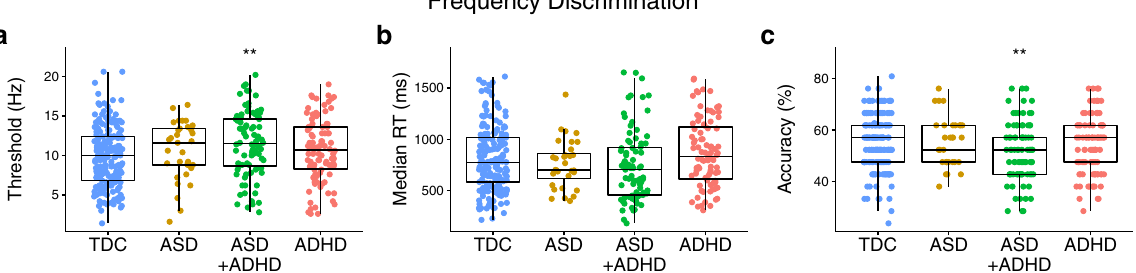
Fig. 4 Group comparisons made on performance outcomes from the frequency discrimination protocol. Individual data points with overlaid boxplots visualizing the group comparisons on key performance outcomes on the frequency discrimination protocol, including a frequency discrimination threshold, b reaction time, and c accuracy. As with amplitude discrimination thresholds, after controlling for age, only the ASD + ADHD group had higher frequency discrimination thresholds than the typically developing control group. Note that all statistical analyses presented in the main text of the manuscript for the plots presented in this fi gure are age-corrected. Values in the plots presented within this fi gure are not corrected for age due to the loss of interpretability of units of measurement that occurs when presenting residuals rather than raw values. The precise number of participants in each group and further descriptive statistics can be found in Supplementary Methods, Supplementary Table 1. * p < 0.05, ** p < 0.01, *** p < 0.001, TDC typically developing controls, ASD autism spectrum disorders, ADHD attention-de fi cit hyperactivity disorder, RT reaction times.